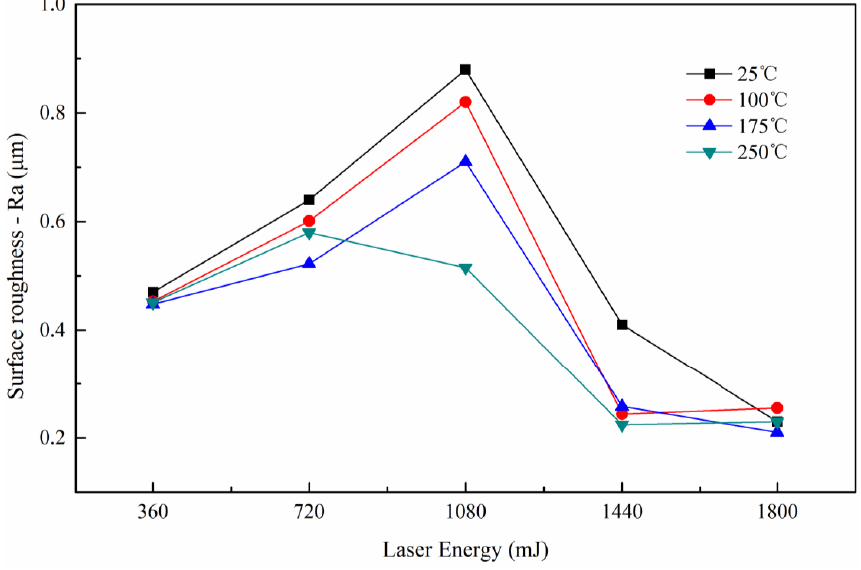
Figure 7. Influences of forming temperature and laser energy to surface roughness.